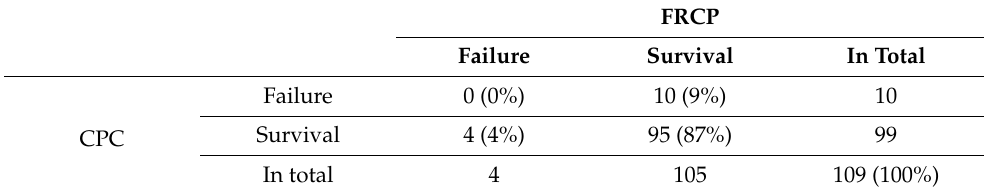
Table 1. Results for the primary endpoint.